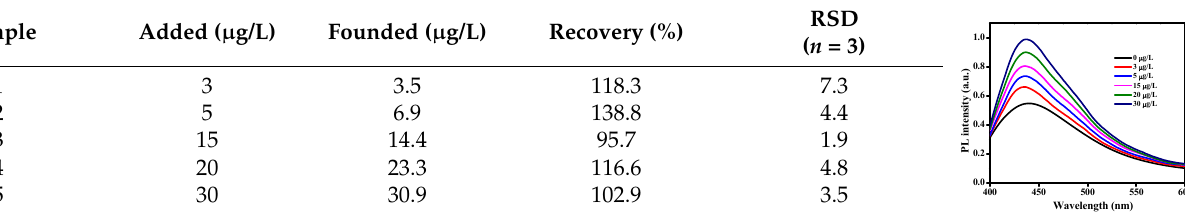
Table 2. Detection of MFH in human